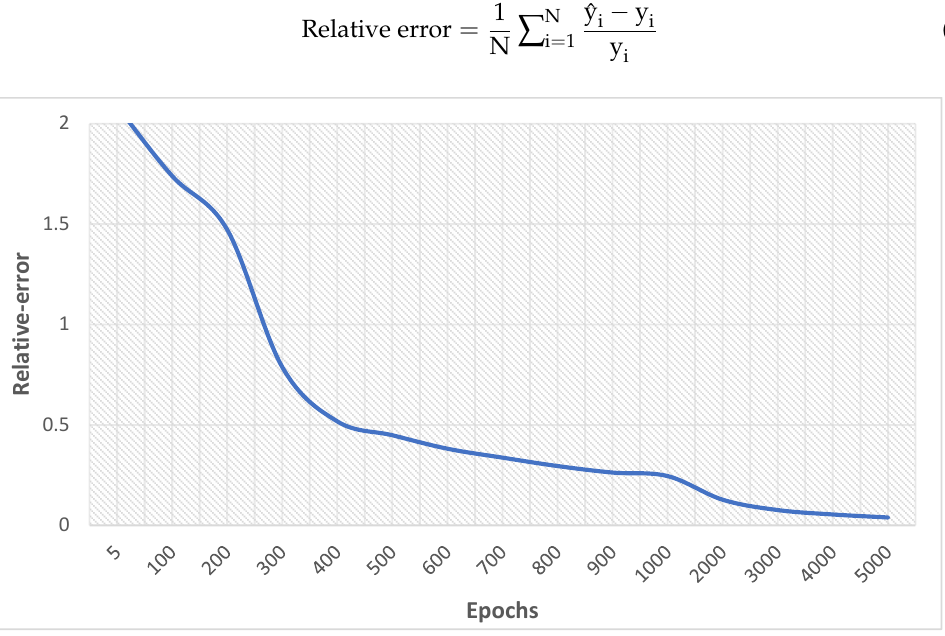
Figure 9. The Re-error of Test Data.